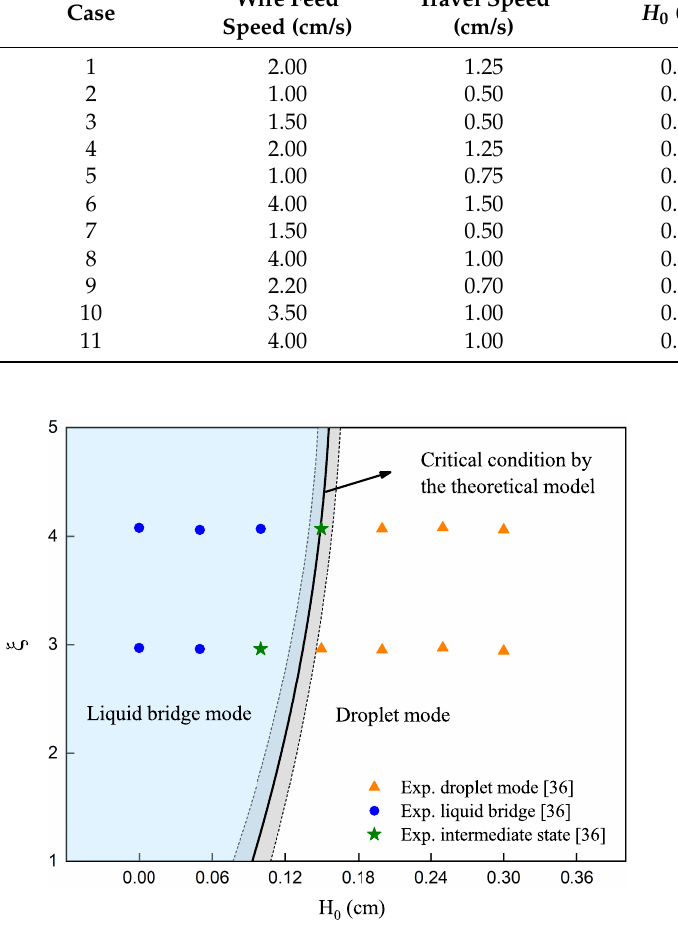
Figure 11. Liquid bridge and droplet modes predicted by the proposed model and observed from experiments